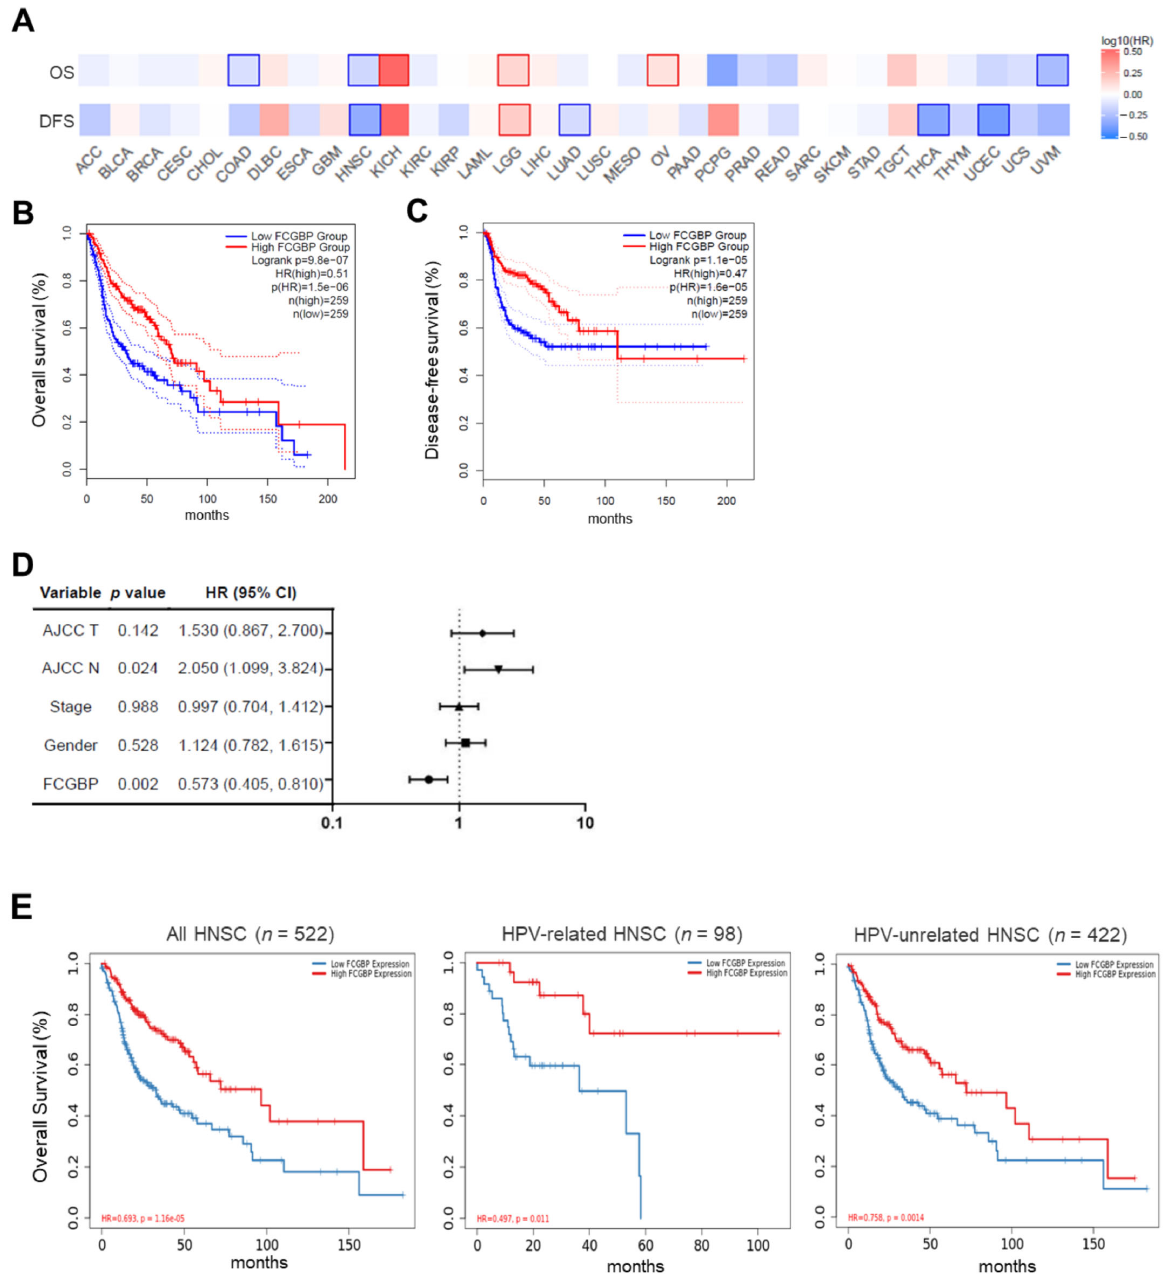
Figure 2. Survival analyses of the FCGBP level in patients with HNSC. ( A ) Gene Expression Profiling Interactive Analysis 2 (GEPIA2) illustrated the heat maps of the overall survival (OS) and disease-free survival (DFS) across various cancer types. ( B , C ) Kaplan–Meier analysis showed OS and DFS of HNSC patients with high FCGBP and low FCGBP levels based on the GEPIA2. ( D ) Univariate Cox analysis reveals the hazard ratios (HR) of different variables. ( E ) Using multivariate analysis, TIMER 2.0 evaluates the OS for all HNSC, HPV-related, and HPV-unrelated